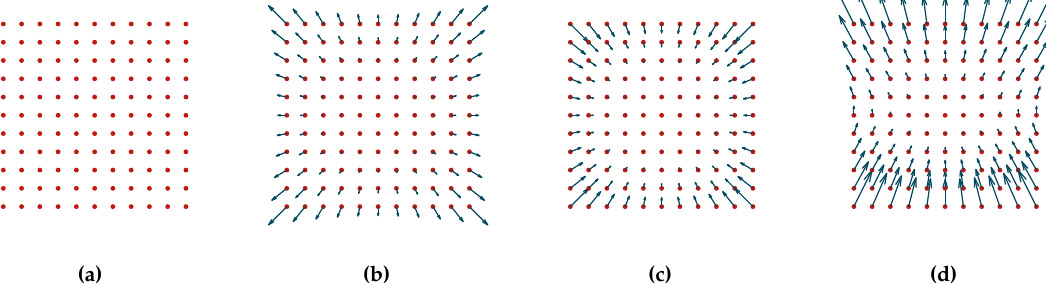
Figure 1. Lens distortion. (a) No distortion, (b) Positive radial distortion (barrel). (c) Negative radial distortion (pincushion). (d) Tangential distortion